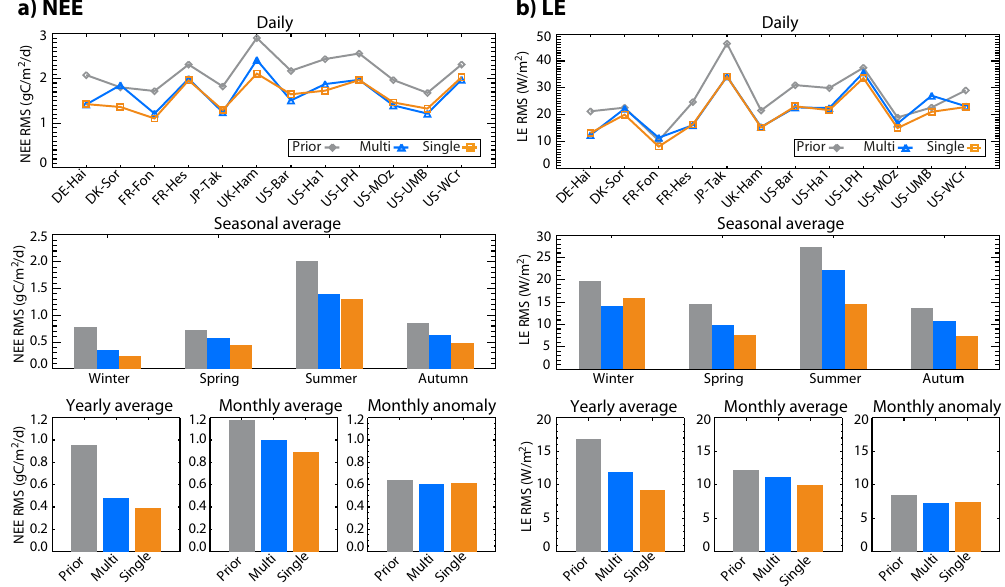
Fig. 3. Model-data RMSs at different time scales for (a) NEE and (b) LE. Prior model is in grey, MS optimization in blue and SS optimization in